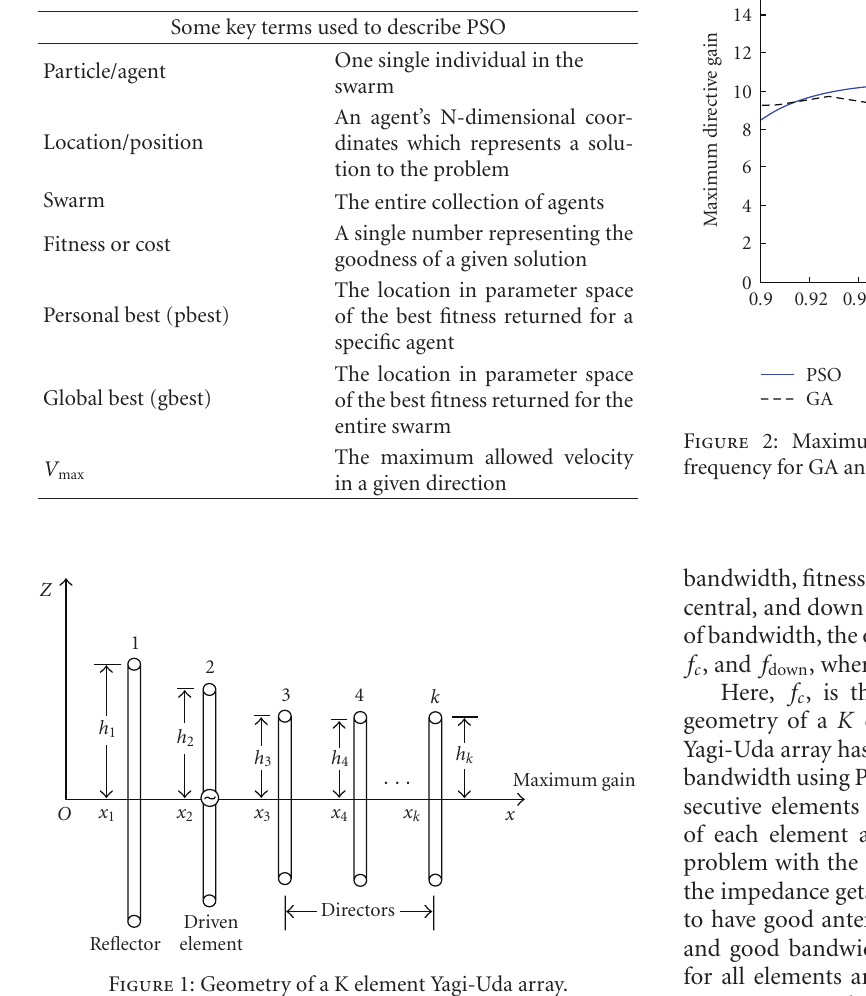
Table 1: Key PSO vocabulary.